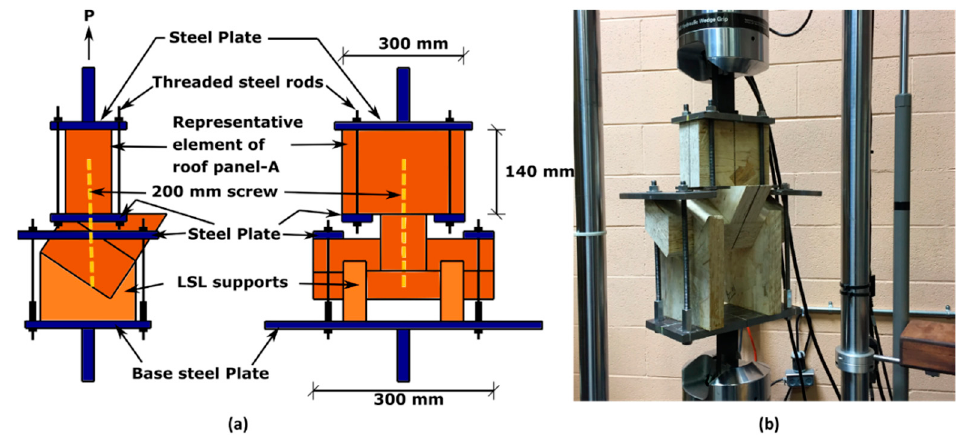
Figure 13. Connection-A withdrawal test setup: ( a ) schematics; ( b ) actual image.